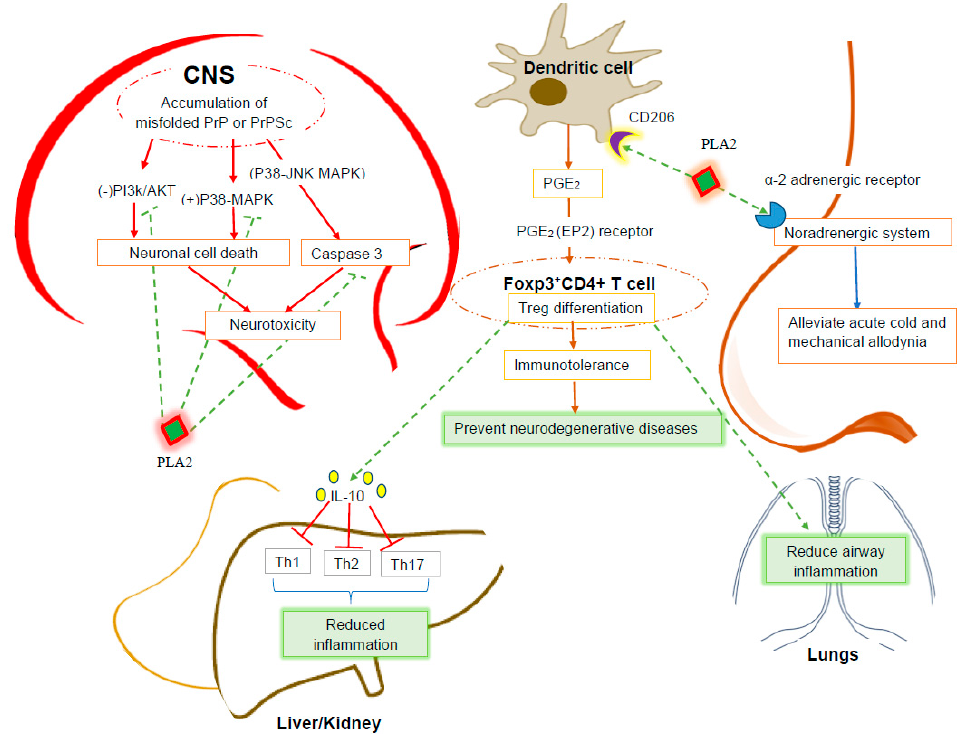
Figure 1. A schematic model of BV PLA2’s mechanism of actions in ameliorating